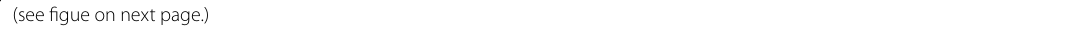
Fig. 5 GPER regulates actin polymerization via YAP-ARHGAP29-RhoA-LIMK-Cofilin Signaling. a Protein expression of YAP in chondrocyte treated with G-1 or mechanical stress